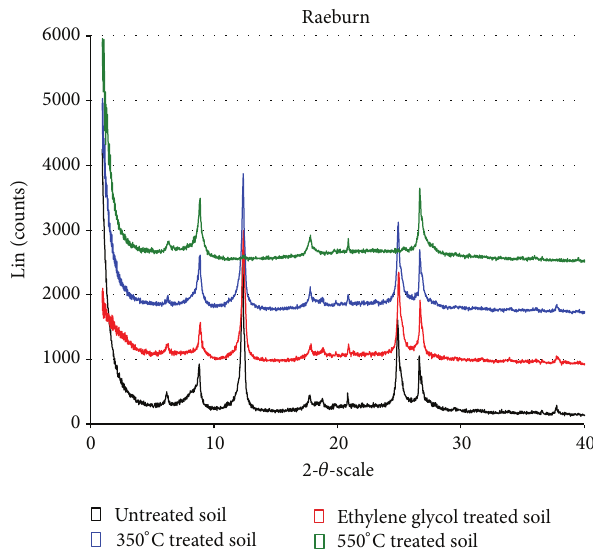
Figure 2: XRD patterns of the Errol soil oriented aggregates.